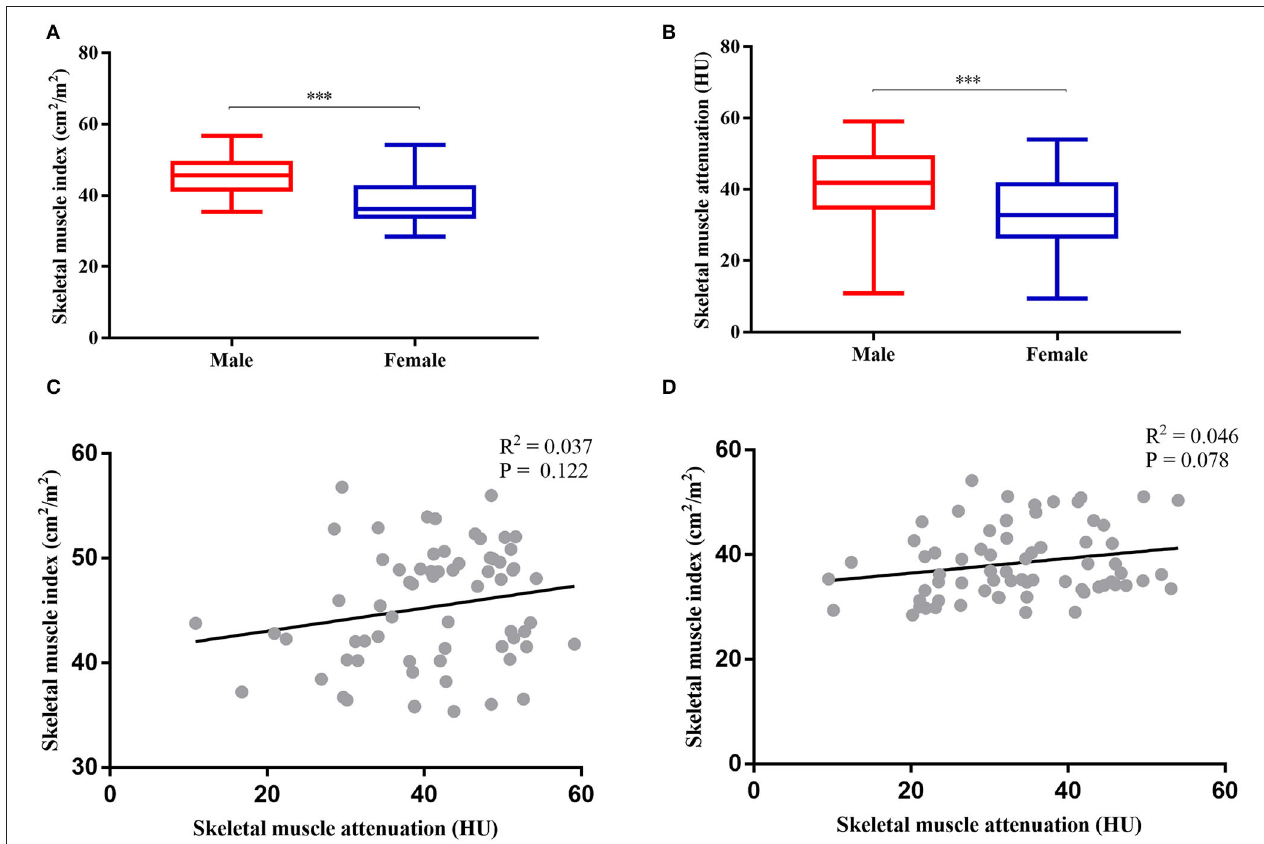
FIGURE 3 | Gender-specific body compositions and their correlation. (A) Comparison between skeletal muscle index (SMI) and sex. (B) Comparison between skeletal muscle attenuation (SMA) and sex. (C) Correlation between SMI and SMA in women. (D) Correlation between SMI and SMA in men. *** P < 0.001.